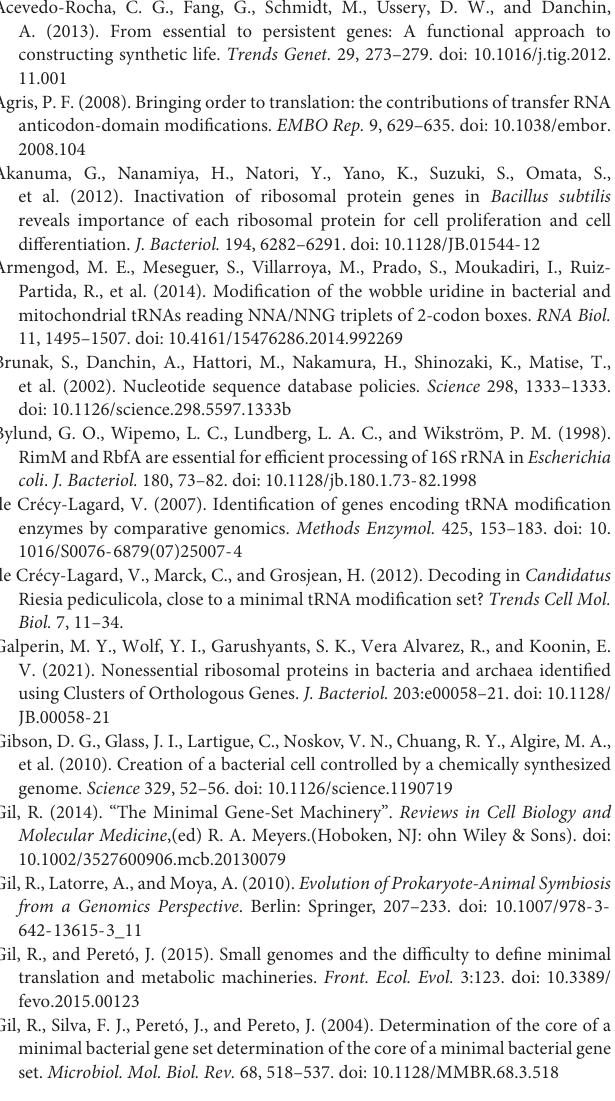
Supplementary Figure 1 | Dendrograms obtained as a result of HCA for cosym dataset. The analyses have been performed for each translational subprocess (legend A) considering clades (legend B).